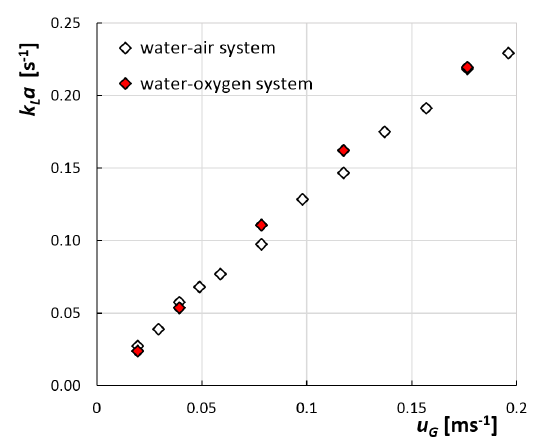
Figure 6. Effect of gas phase composition on resulting volumetric mass transfer coefficient.